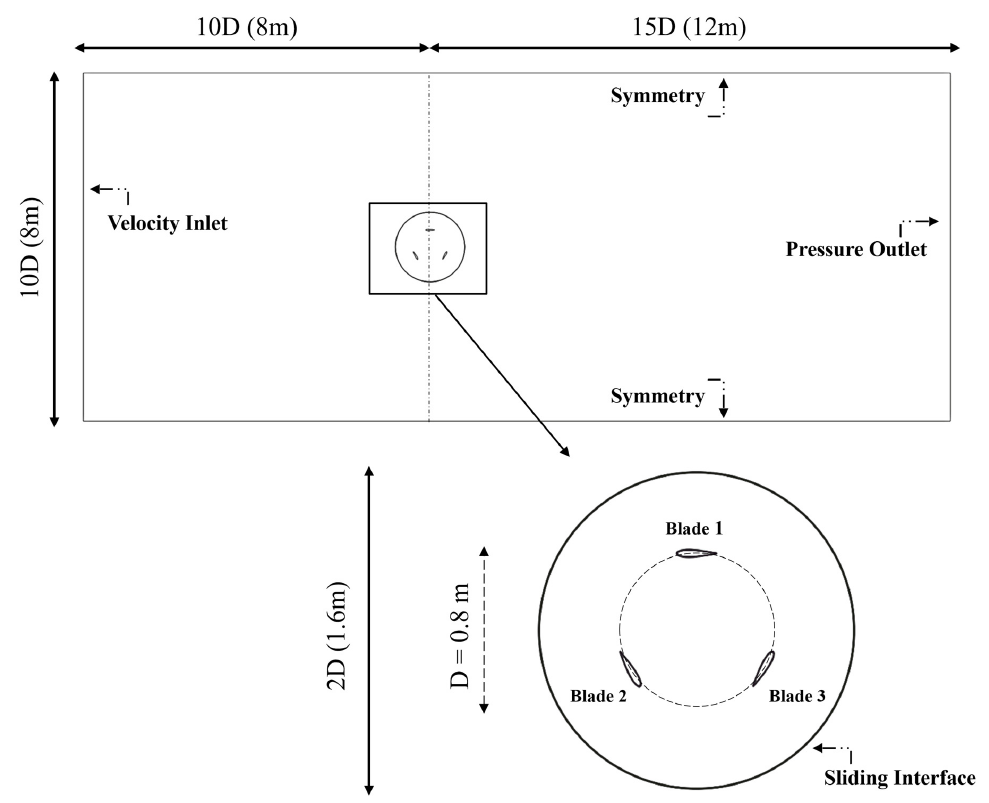
Figure 3. Description of the Computational Domain and Boundary Conditions Used for Calcula ‐ tions.